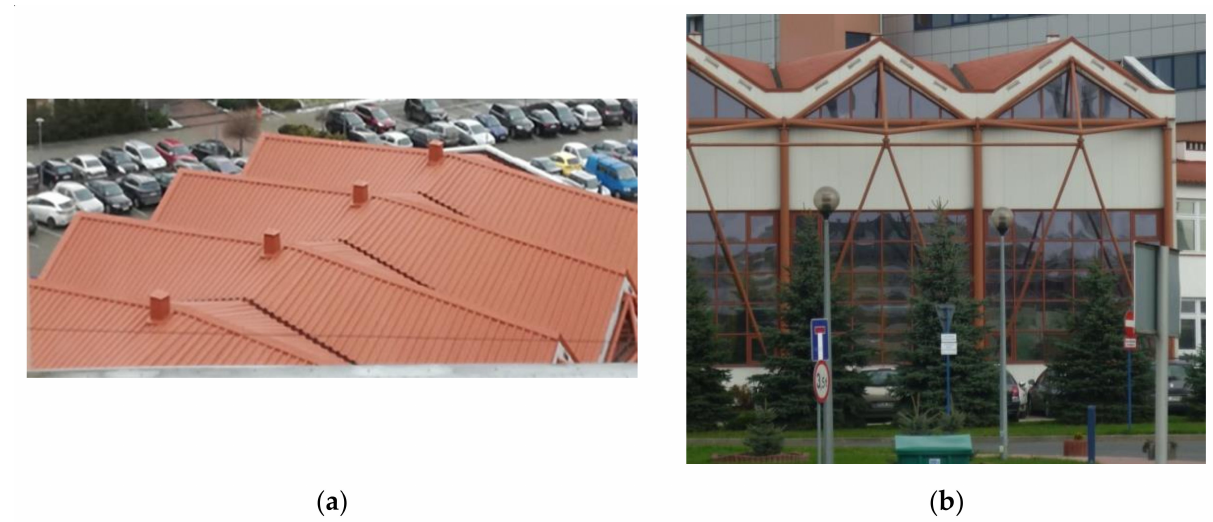
Figure 5. The external views of two opposite elevations of the experimental hall at a university roofed with the shell structure: ( a ) the roof structure; ( b ) the south side of the entire building.